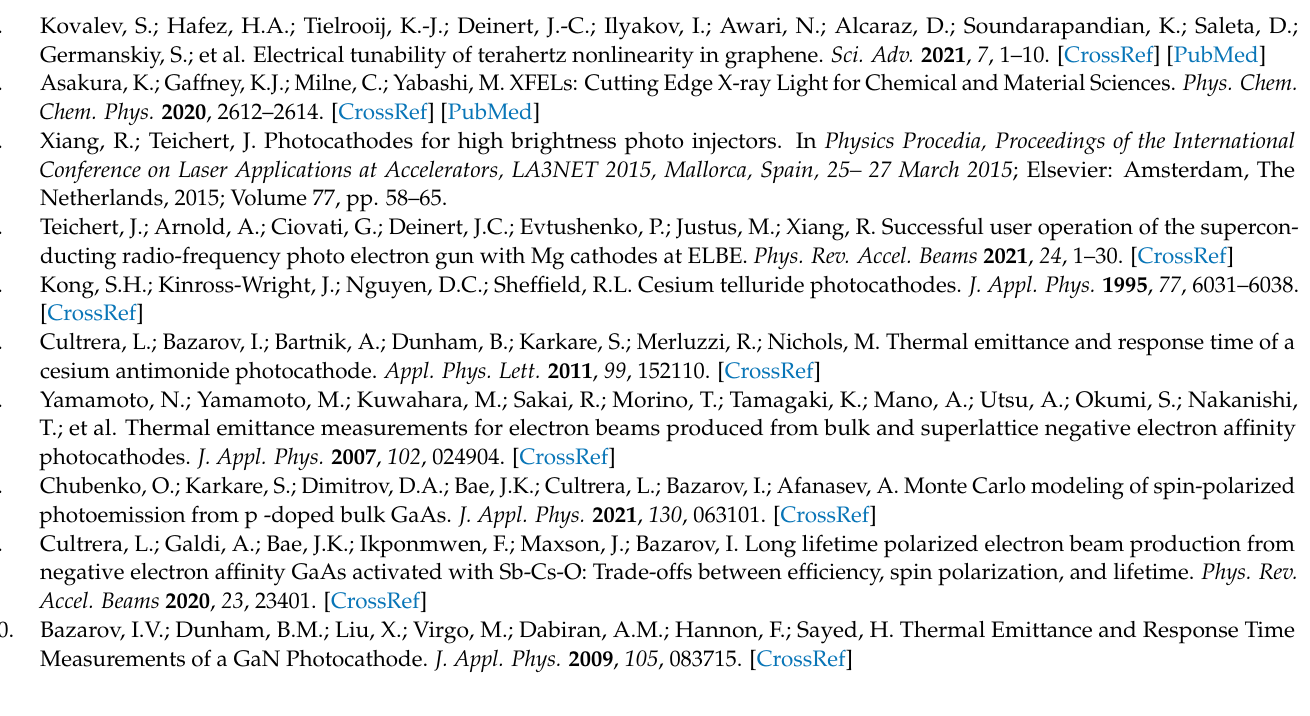
Figure S3: EDX measurement of p-GaN:Cs on sapphire photocathode (sample A5), showing the homogeneity of the photocathode surface with a Ga:N ratio of 1:1. Figure S4: EDX spectra of p- GaN:Cs on silicon photocathode (sample B2), showing that the round particle contains cesium and oxygen (blue dots), compared to the p-GaN:Cs photocathode surface (black